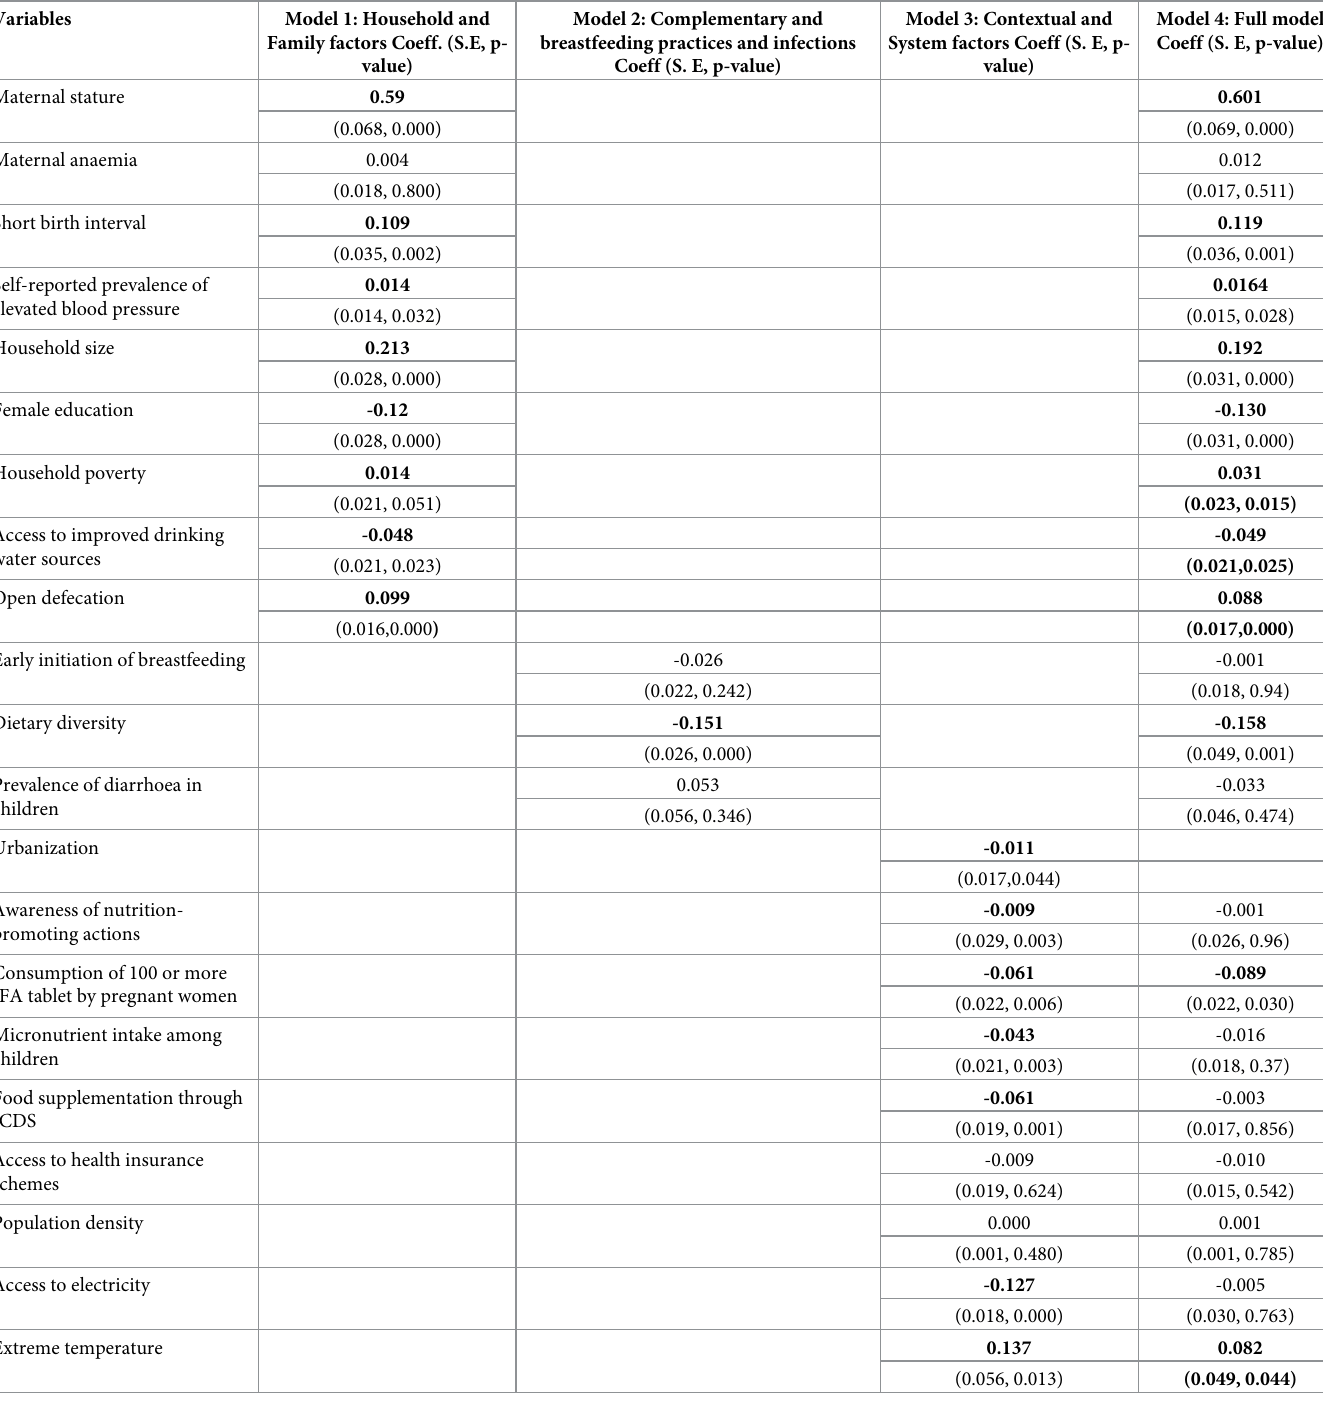
Table 3. Unadjusted and adjusted coefficients for the spatial regression analysis of the risk factors of childhood stunting.